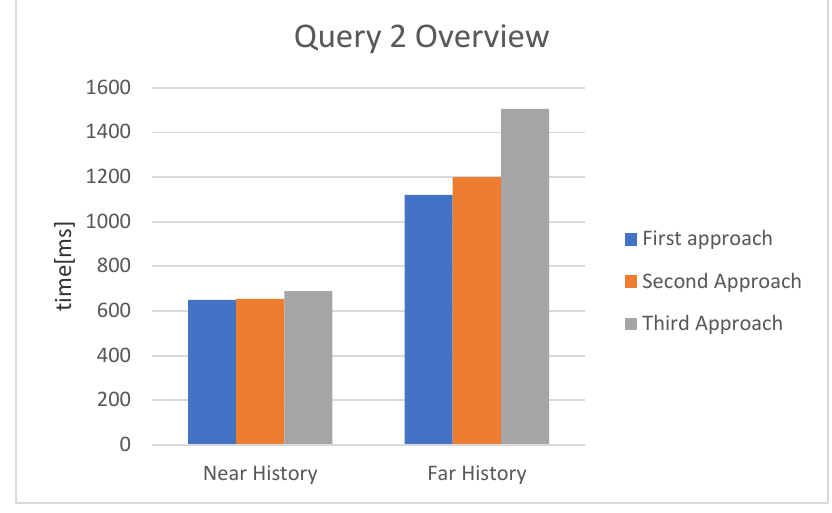
Figure 10. Results for Query 2.